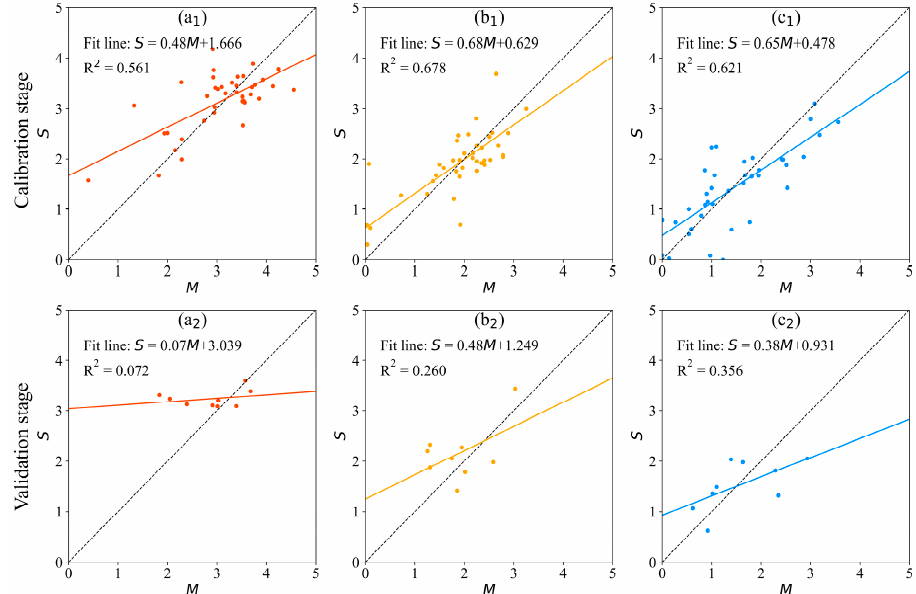
Figure 3. The performance of the MLE models. M : measured values; S : simulated values. Subgraphs ( a – c ) represent P-SWI , Z-SWI , and B-SWI , respectively. Subscripts 1 and 2 represent the calibration stage and the validation stage, respectively.